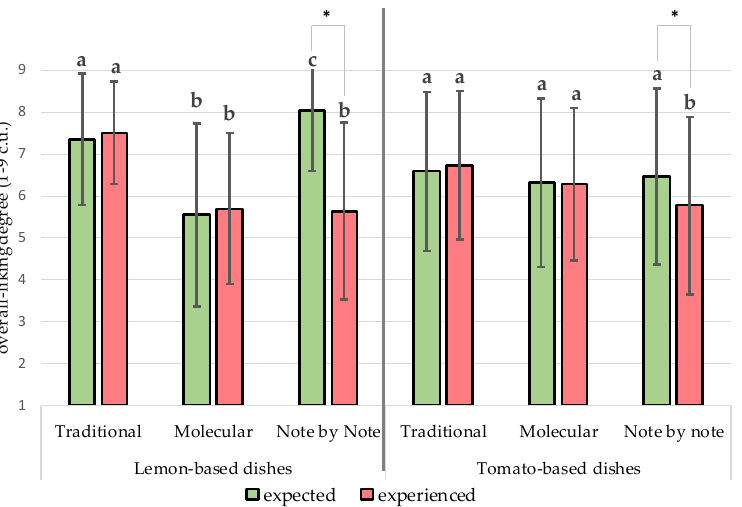
Figure 3. Expected and experienced overall liking in relation to dishes: a, b, c—values of expected- liking or experienced-liking that are marked by different lowercase letters between various versions of dishes with the same main ingredients differ significantly at p ≤ 0.05; * asterisk brackets indicate a significant difference between expected and experienced overall liking of the given sample at p ≤ 0.05.